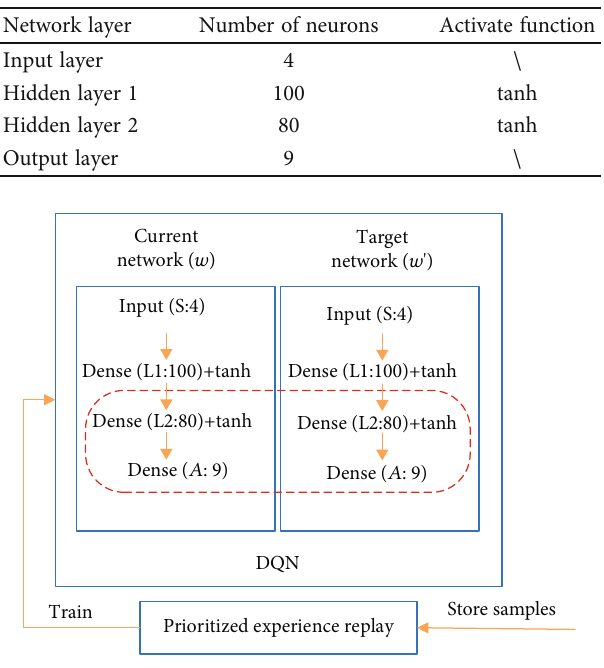
Table 2: Q network structure.